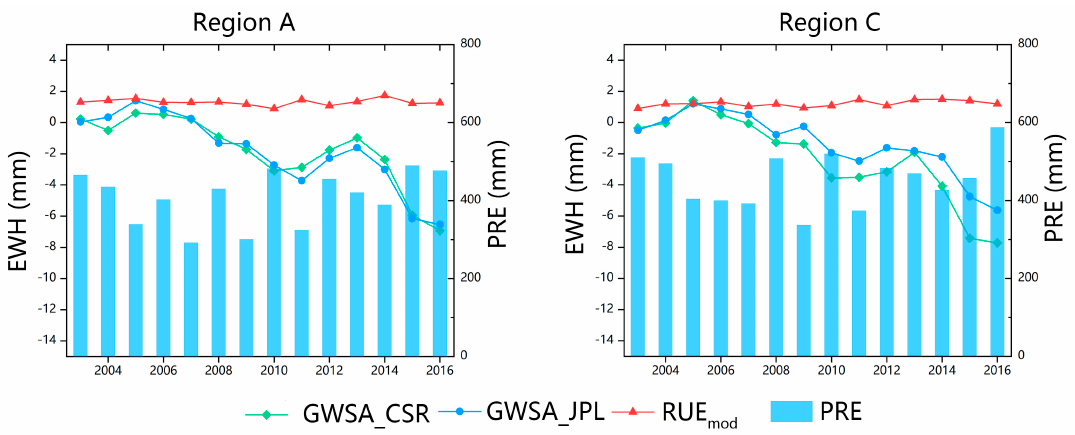
Figure 10. Calculation results of RUE mod . Table 2. Correlation between GWSA and RUE mod in Region A.